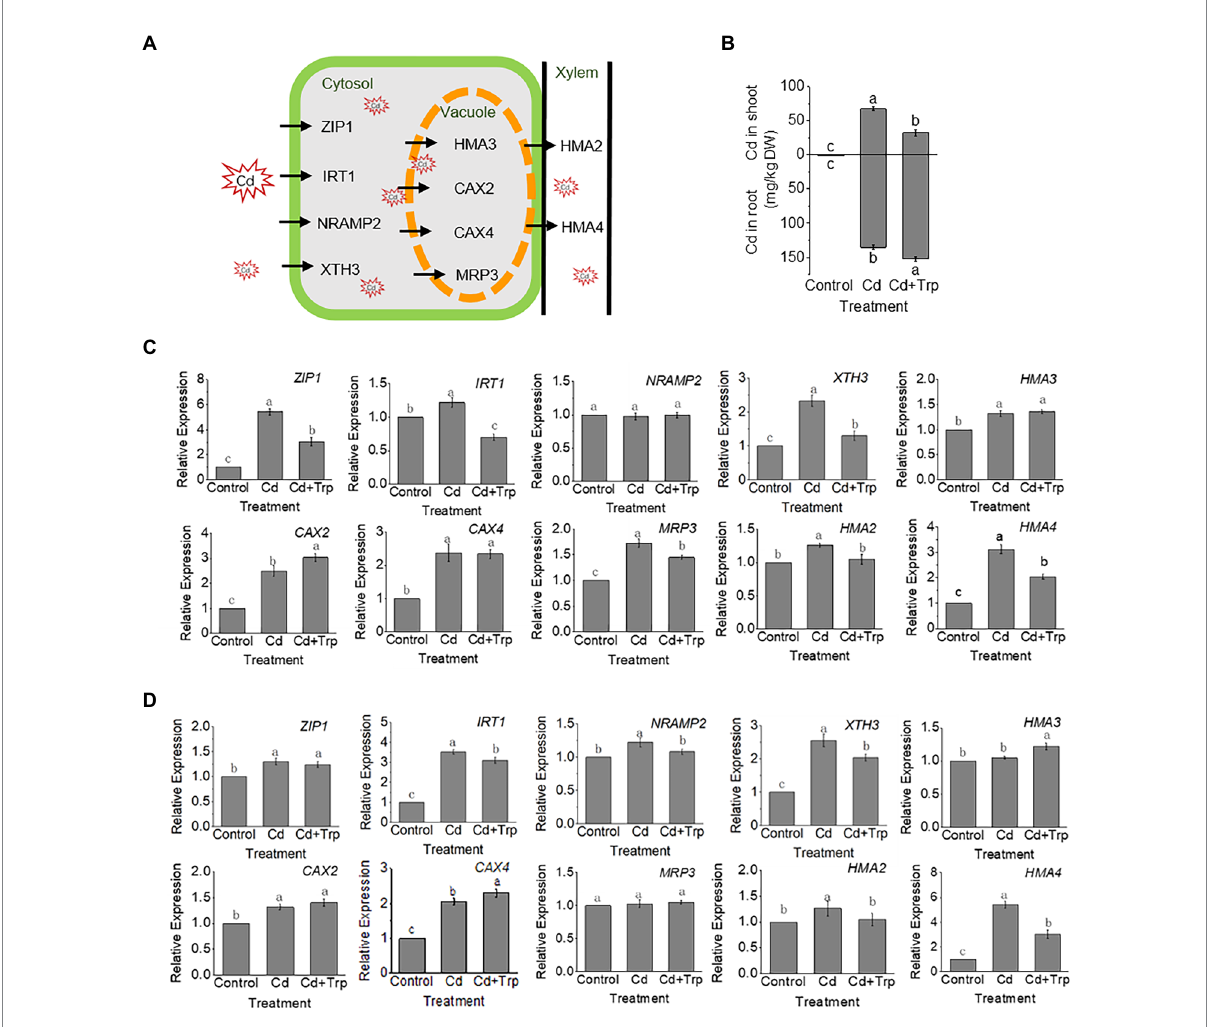
FIGURE 7 Effects of Trp on Cd accumulation and transport under Cd stress. (A) Schematic diagram of key proteins involved in Cd transport. (B) Contents of Cd in shoot and root. (C) Expression of transporter genes in shoot. (D) Expression of transporter genes in root. Expression value of the control sample without treatment is set to 1. Relative gene expression values in comparison with the control are shown. Data were averaged from three independent replicates ± SD. Different letters represent significant differences between different treatments ( p ≤